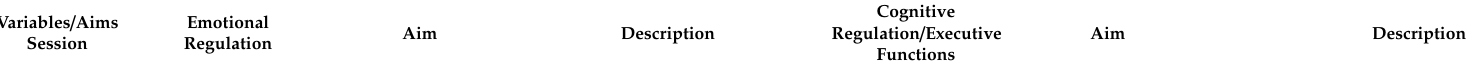
Inhibitory control Working memory